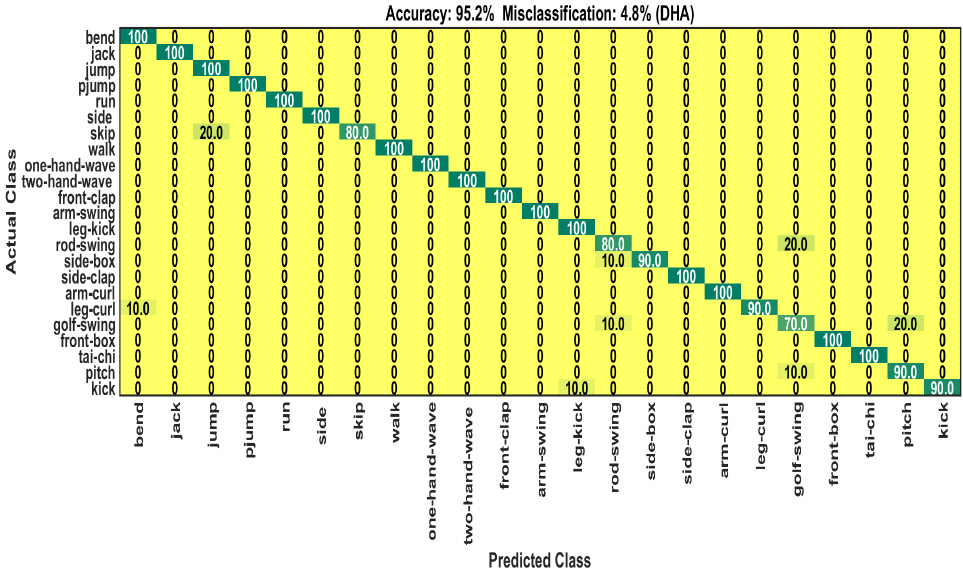
Figure 8. Accuracy and loss of our system for DHA dataset using AdaMax optimizer of 0.001 learning rate on 500 epochs.